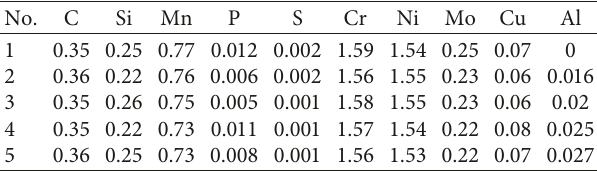
Table 1: Chemical composition of 34CrNiMo6 steel.